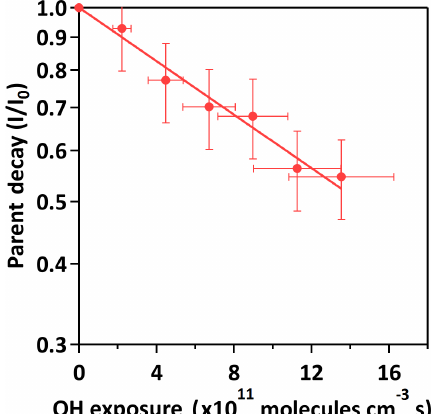
Figure 3. The normalized parent decay as a function of OH ex- posure during the heterogeneous OH oxidation of potassium 3- methyltetrol sulfate ester at